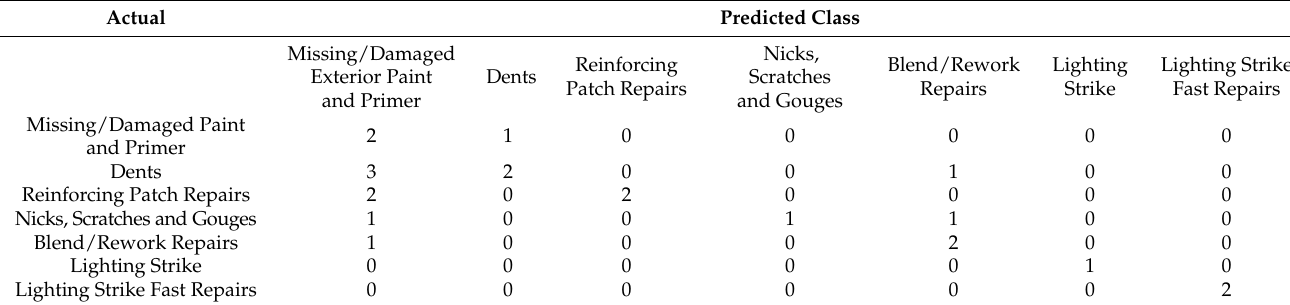
Table 10. Confusion natrix for Dense 169.